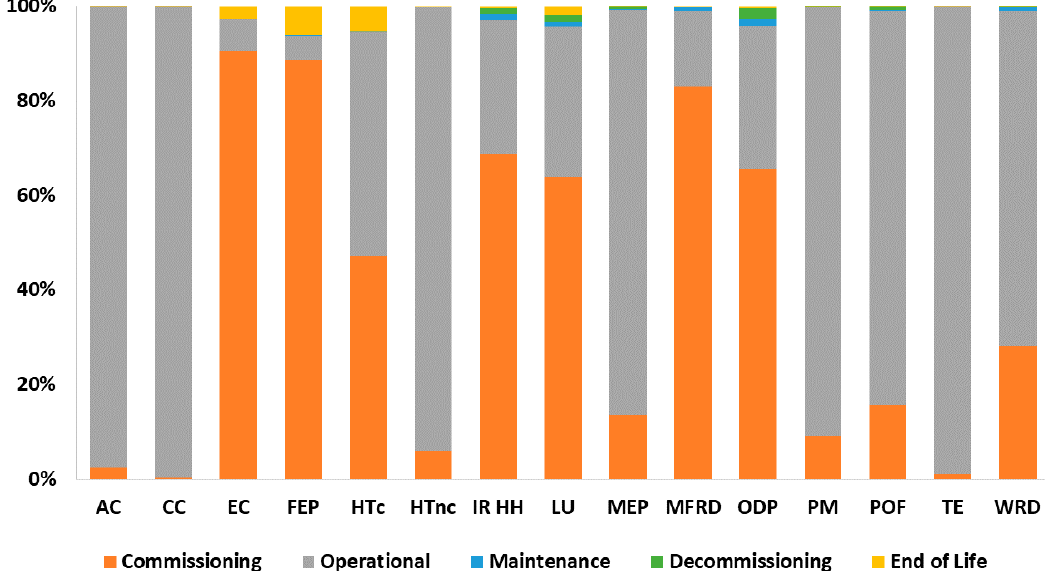
Figure 2. Percentage of contribution of commissioning, operation, maintenance, decommissioning and EoL phases to the total impact in all the assessed impact categories.